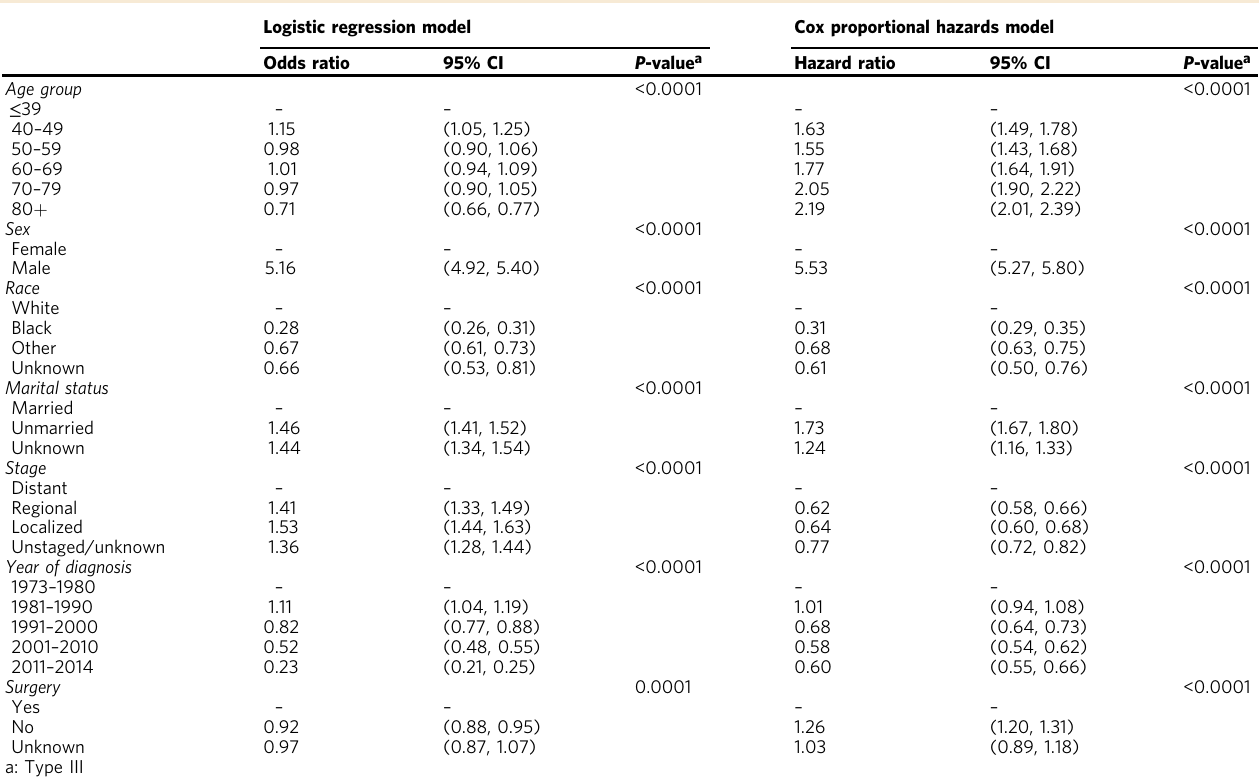
Table 2 Odds ratios and hazard ratios of suicide among cancer patients Logistic regression model Cox proportional hazards model